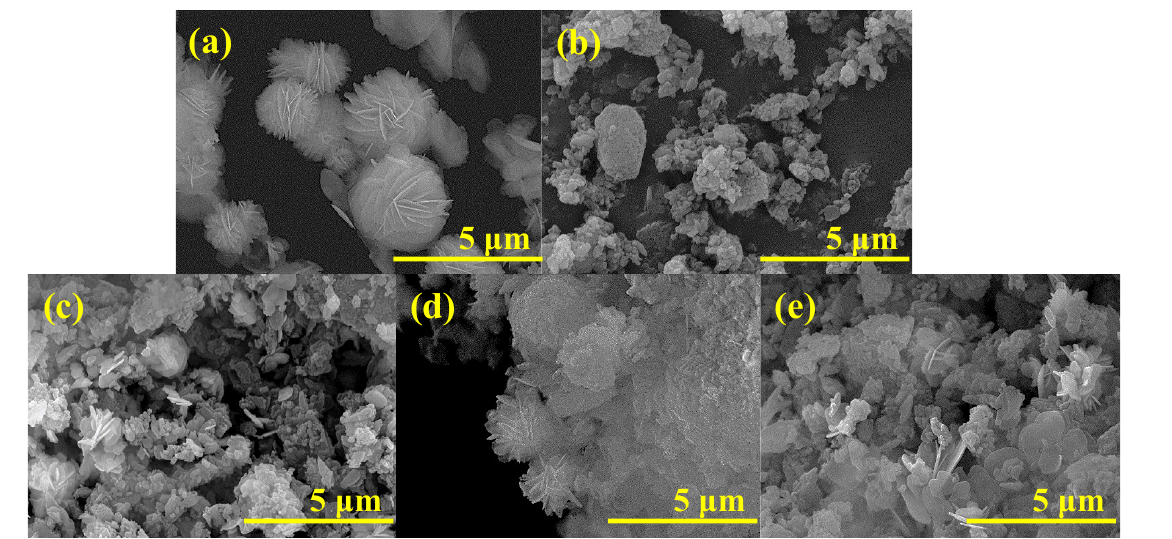
Figure 7. SEM images: ( a ) BiOI, ( b ) mordenite, ( c ) BiOI/mordenite composite synthesized at 153 °C during 20.3 h, ( d ) BiOI/mordenite composite obtained at 180 °C during 7 h, ( e ) optimized BiOI/mordenite composite synthesized at 187 °C during 9 h.